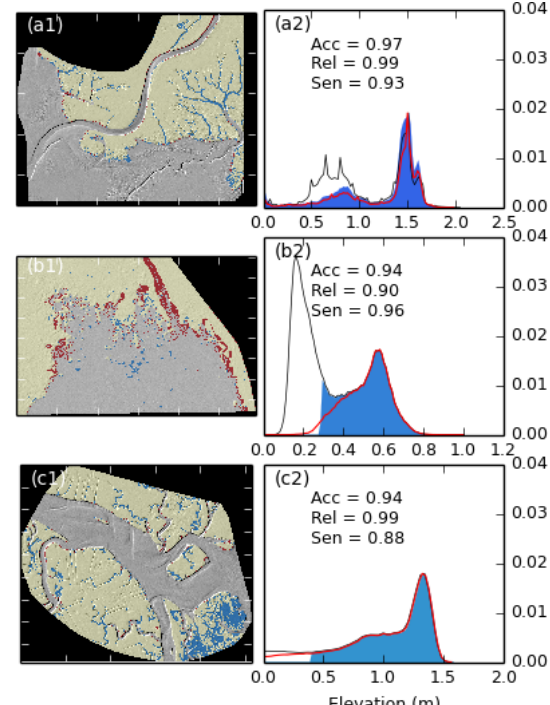
Figure B2. This figure combines the map found in Fig. 10 (a1, b1, c1) and the probability distribution functions in Fig. 9 as well as the values of accuracy, precision, and sensitivity for sites A1 to A3 (a2, b2, c2) . Each DEM was processed at its native resolution of